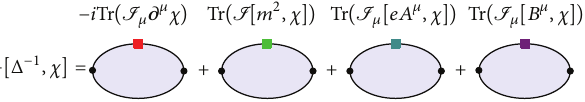
Figure 1: Schematic representation of the gWTI for the pion propagator with broken isotopic symmetry. The blobs denote the dressed vertices. The first one is a Lorentz vector entering the pion 𝛽 decay. The last three are Lorentz scalars; they are responsible for the symmetry breaking by the pion masses and the electromagnetic and weak